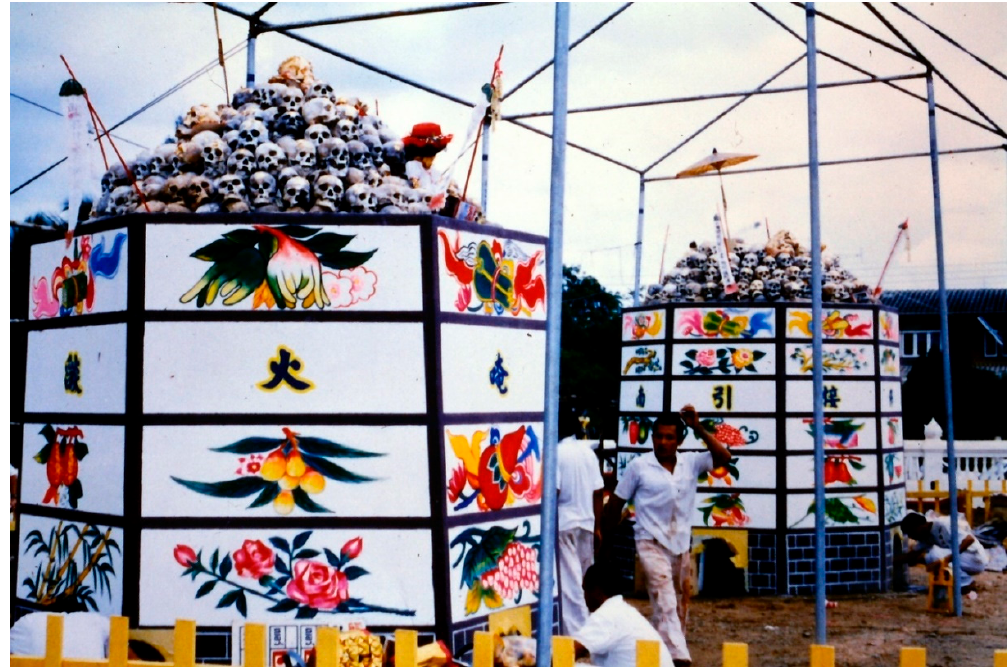
Figure 4. The two chimney stakes containing skeletons, Roeit, Thailand, 1994 (© B.